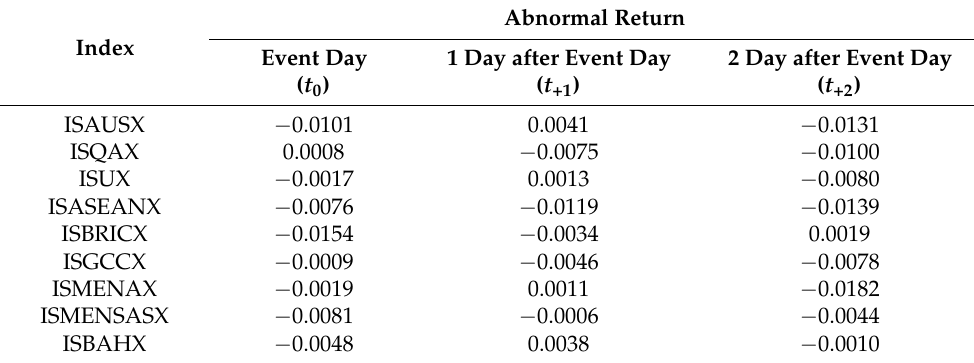
Table 3. Abnormal return on event date and one day after.